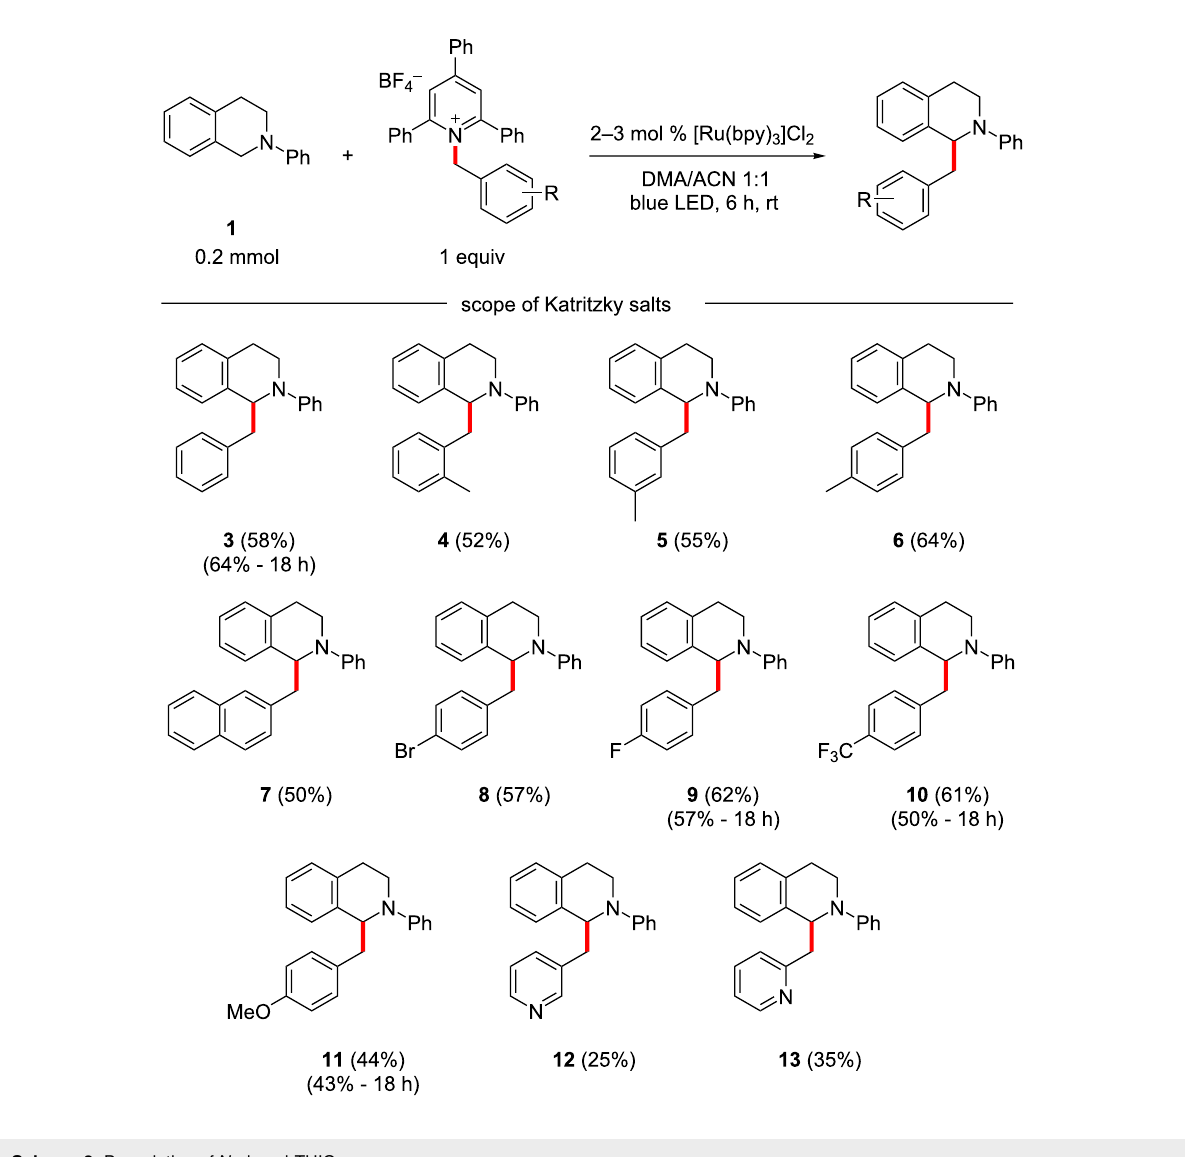
Scheme 2: Benzylation of N